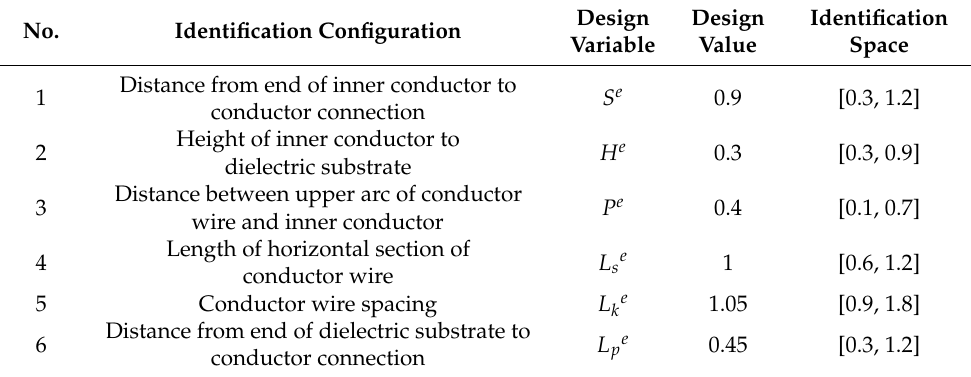
Figure 6. Comparisons of the measured scattering parameters with simulated results. Table 5. Design variables, design values and identification space of flexible